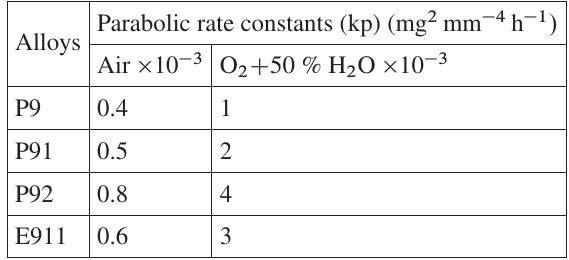
The higher oxidation rate of P92 alloys obtained in O 2 C 50 %H 2 O condition compared to other alloys may be due to high concentration of active element tungsten (W) present in the inner scale (Figure 12). Presence of W is con- firmed by EDAX analysis carried out at different location of oxide scale. The concentration of tungsten (W) is 9.54 and 7.96 (atomic weight percentage (mass %)) inner ox- ide scale. However E911 alloy show that the concentration of active element W and Nb in the oxide is less compared to P92 alloy (Figure 11). This is confirmed with EDAX, the values are 4.74 and 2.36 (mass %)) for W and Nb in the oxide scale. Also confirmed with oxide scale thickness measured values are 150 (cid:2) m for E911 alloy (Figure 11) and 214 (cid:2) m for P92 alloy (Figure 12). The same types of oxide thickness were obtained in the earlier results